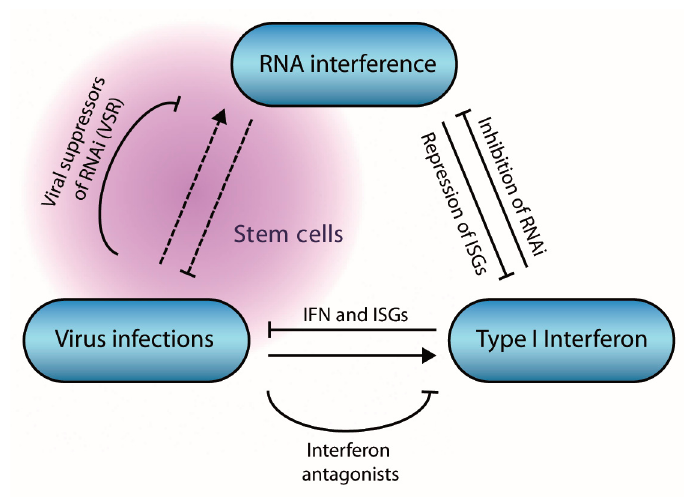
Figure 6. Interactions between viruses, RNA interference (RNAi), and the interferon pathway in mammals. Virus infection induces the expression of type I interferons, leading to the expression of Interferon stimulated genes (ISGs) that collectively restrict virus infection. The interferon pathway inhibits RNAi via multiple mechanisms, whereas miRNAs inhibit expression of ISGs. Virus infection induces an antiviral RNAi response under specific conditions, in stem cells or in absence of viral suppressors of RNAi.